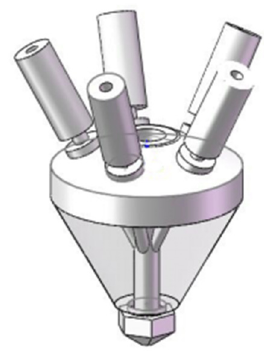
Figure 1. Five-inlet nozzle structure.